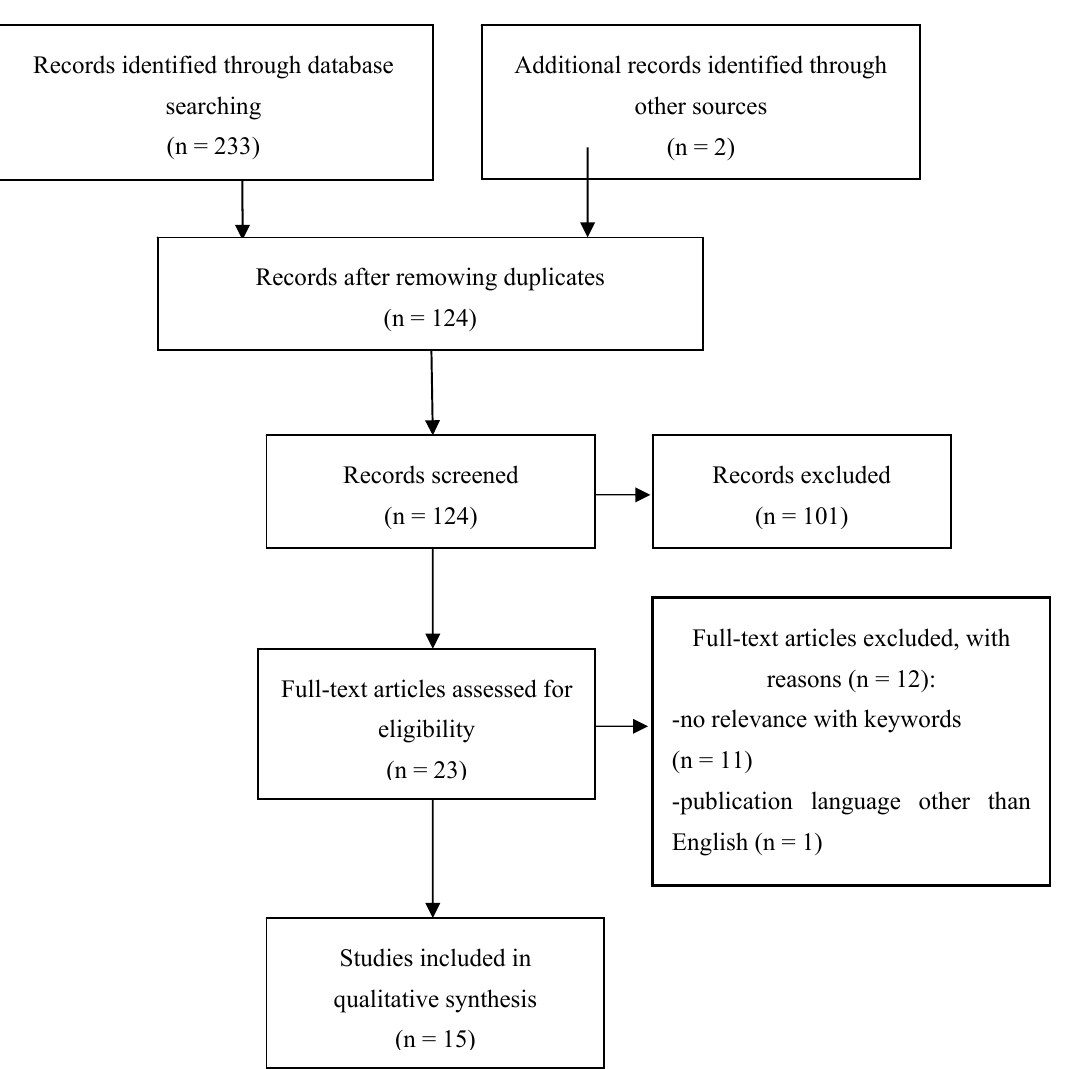
Figure 1. Flow diagram of search and selection process of scoping